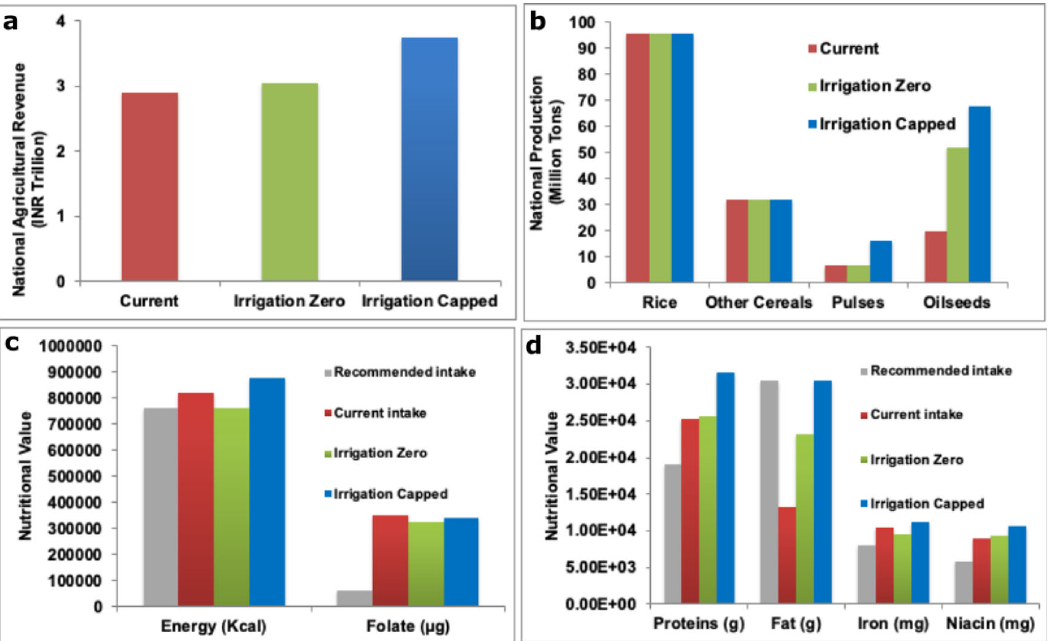
Fig. 2 Comparison of current vs. optimal national revenue, crop production, and nutritional value. a Current vs. optimal national agricultural revenue. b Current vs. optimal national production levels. c Current vs. optimal nutritional value for energy and folates. d Current vs. optimal nutritional value for proteins, fats, iron, and niacin. For nutritional value, the recommended intake is also